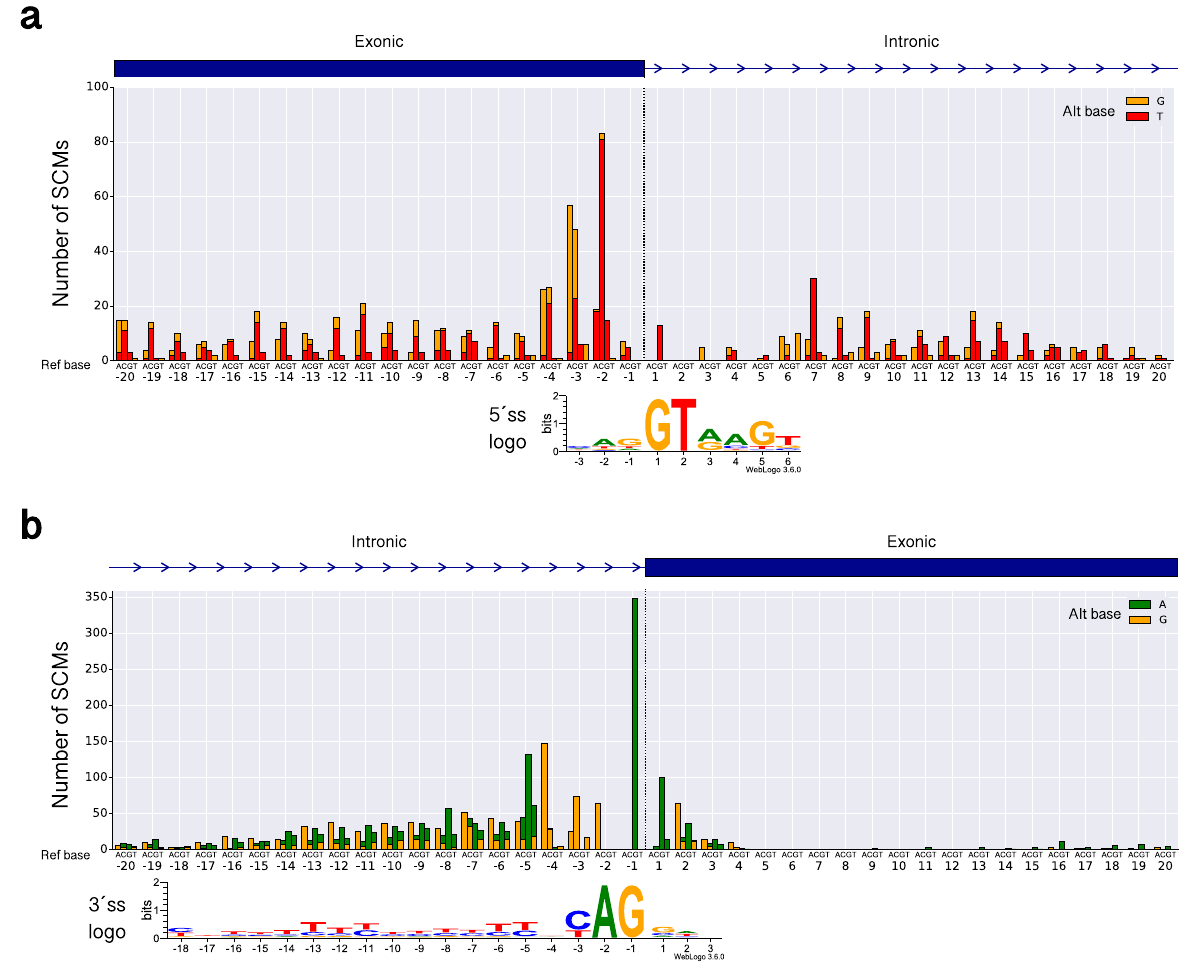
Fig. 3 Positional frequency and spectrum of SCMs. a 5 ′ ss. b 3 ′ ss. The positions of SCMs within 20 bp upstream and downstream of annotated splice sites, respectively, are shown in each panel. The dotted vertical line indicates the annotated original exon – intron boundary. The color codes for alternative bases are shown on the right side of each panel. Note that, in each panel, there are only two alternative bases because we only considered variants that create GT (for 5 ′ ss) or AG (for 3 ′ ss). The SCMs that are more than 20 bp distant from the annotated original exon – intron boundary are not shown. The information content at each splice site is calculated based on the base composition of intron – exon boundaries annotated in GENCODE 48 (version 29) and converted to the sequence logo representation using WebLogo 3 57